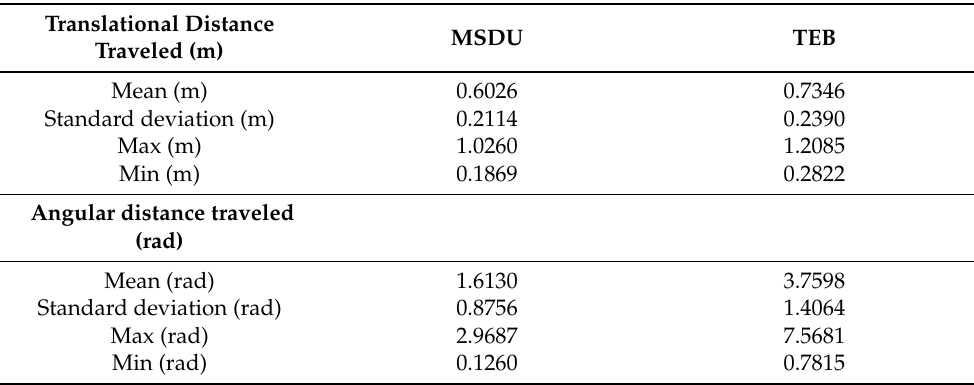
Figure 12. Distance traveled between the starting and final robot pose for the MSDU Local Planner (black) and the TEB Local Planner (white) over short (<1 m) paths. ( a ) Translational distance traveled between the starting and final robot pose; ( b ) angular distance traveled between the starting and final robot pose. Table 6. Summary of distances traveled by MSDU and TEB for short